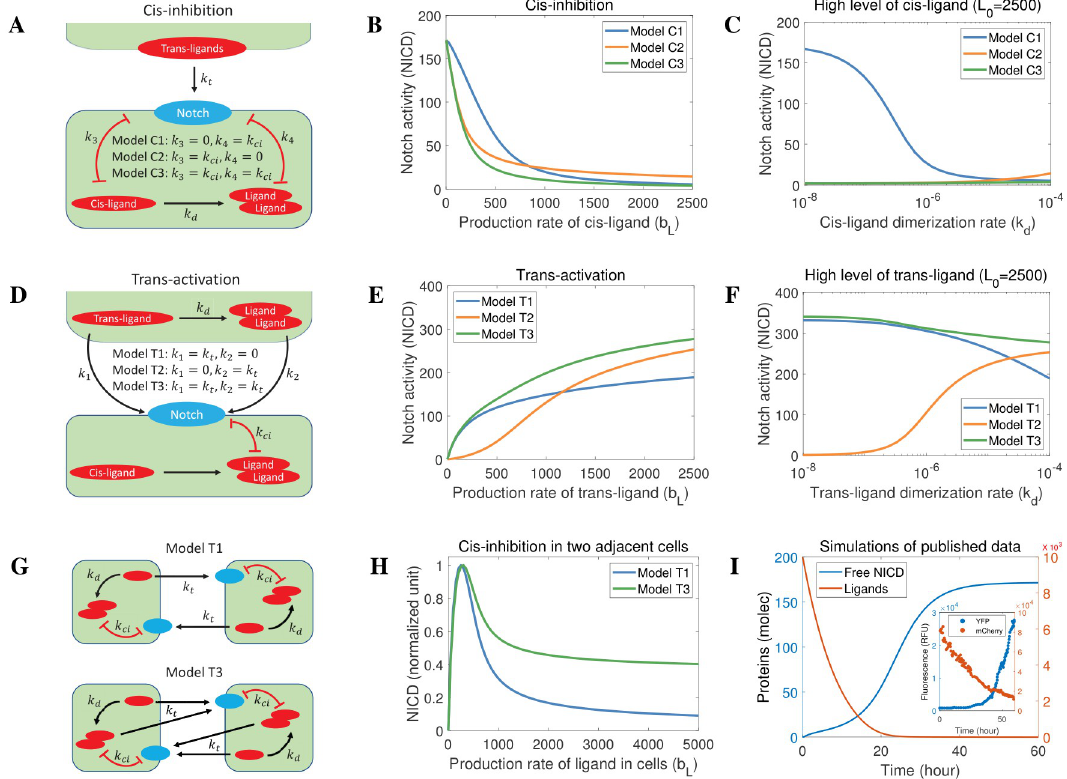
Fig 6. The role of Notch ligand monomers and dimers in Notch receptor cis-inhibition and trans activation. (A) The potential models governing cis-inhibition of Notch. The level of trans-ligand in sending cell is fixed whilst cis ligand levels in receiving cell vary as shown. (B) Notch activity in the receiving cell as a function of cis-ligand production rate for the different models shown in A. (C) Notch activity in the receiving cell as a function of cis-ligand dimerization rates for a high level of cis-ligand (the maximum production rate shown in B). (D) The potential models governing trans-activation of Notch. The production rate and dimerization rate of ligand in the receiving cell is fixed whilst trans ligand levels in sending cell vary as shown. (E) Notch activity in the receiving cell in response to increasing trans-ligand production rates for the different models shown in D. (F) Notch activity in the receiving cell in response to decreasing trans-ligand dimerization rates when the level of trans-ligand is high (the maximum production rate shown in E). (G) The potential roles of ligand monomer and ligand dimer governing Notch signaling in two identical cells. (H) Relative Notch activity in response to increasing Notch ligand production rates in two cells for the two cases shown in G. Notch activity is normalized against the maximum Notch activity. (I) In silico replication of published cis-inhibition dynamics [22]. In common with their experimental conditions [22], the initial state of ligand levels is high (with a production rate of 0), whilst Notch receptor levels are